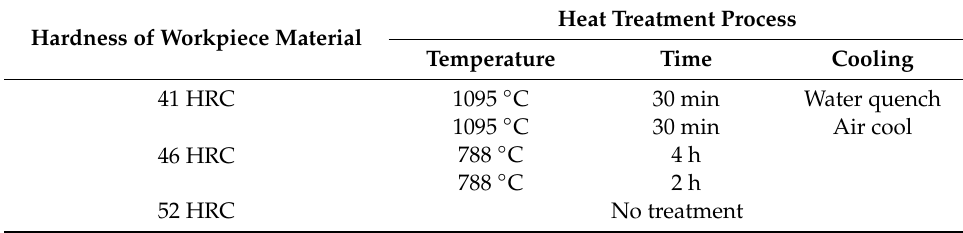
Table 4. Heat treatment processes for the distinct workpiece samples.